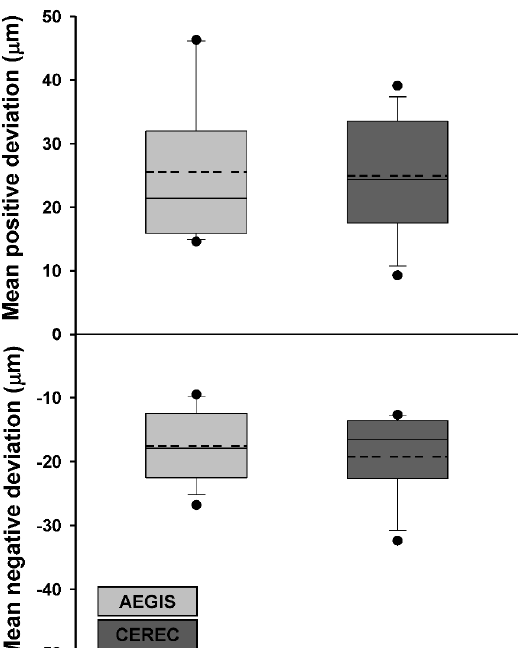
Figure 10. Box plot of the mean positive and negative deviations after superimposition of the CI dataset with datasets obtained from the AEGIS and CEREC scans.